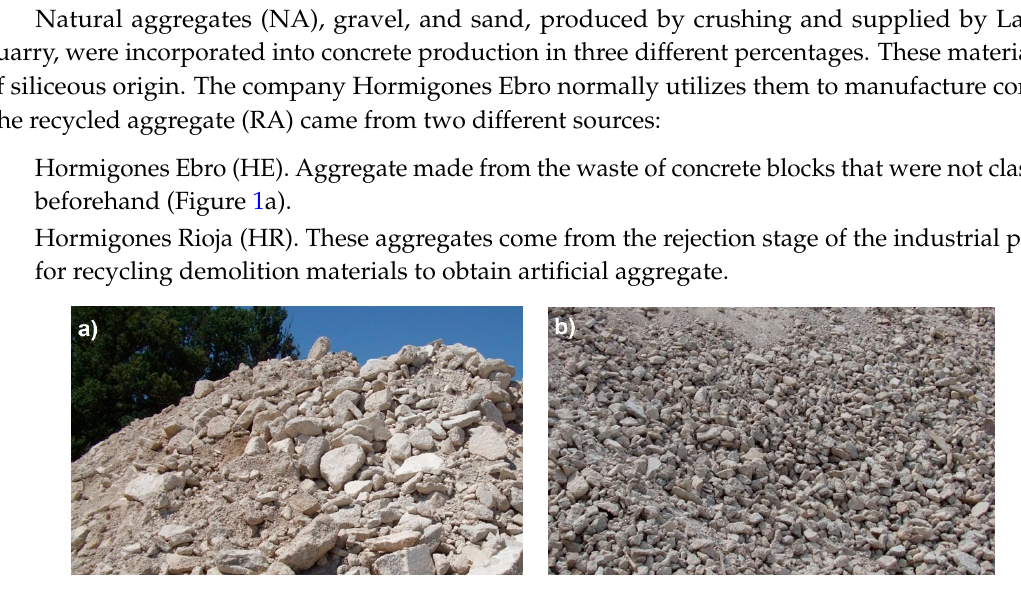
Figure 1. ( a ) Concrete waste. Source: Hormigones Ebro; and ( b ) demolition waste. Source: Hormigones Rioja.